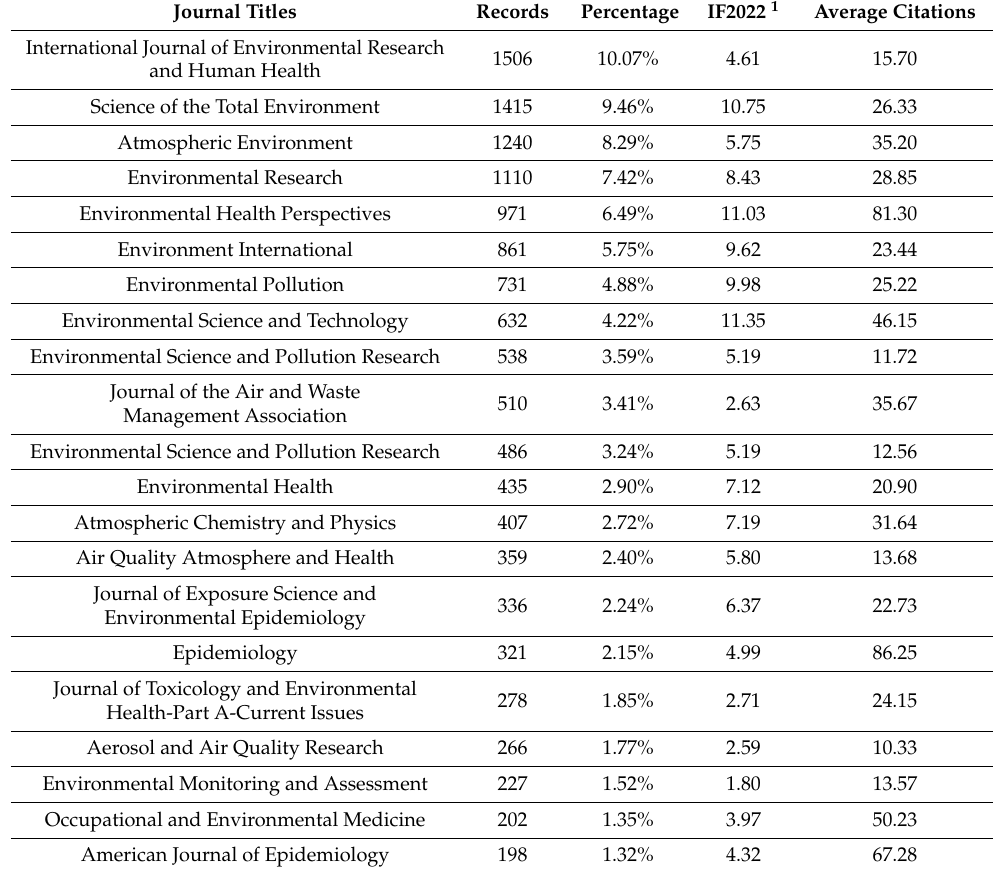
Table 1. The top 20 most productive journals.